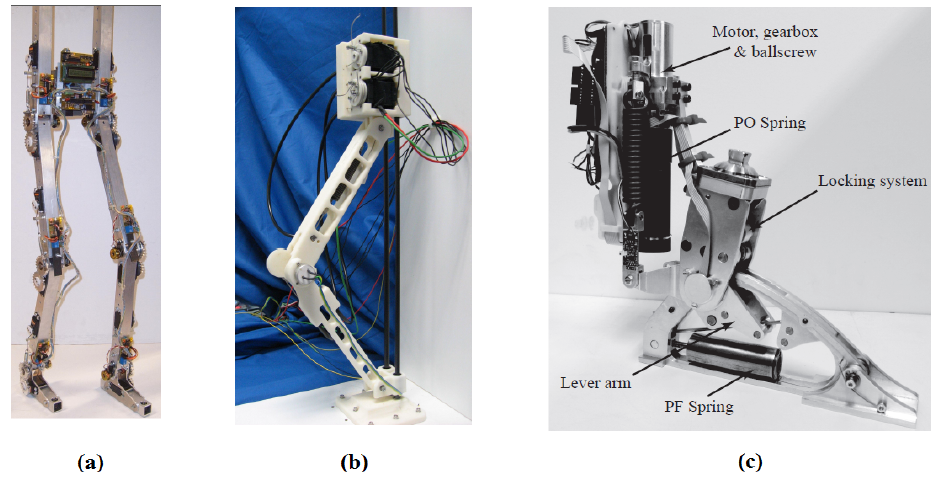
Figure 2. Applications using the MACCEPA: a bipedal walker ( a )